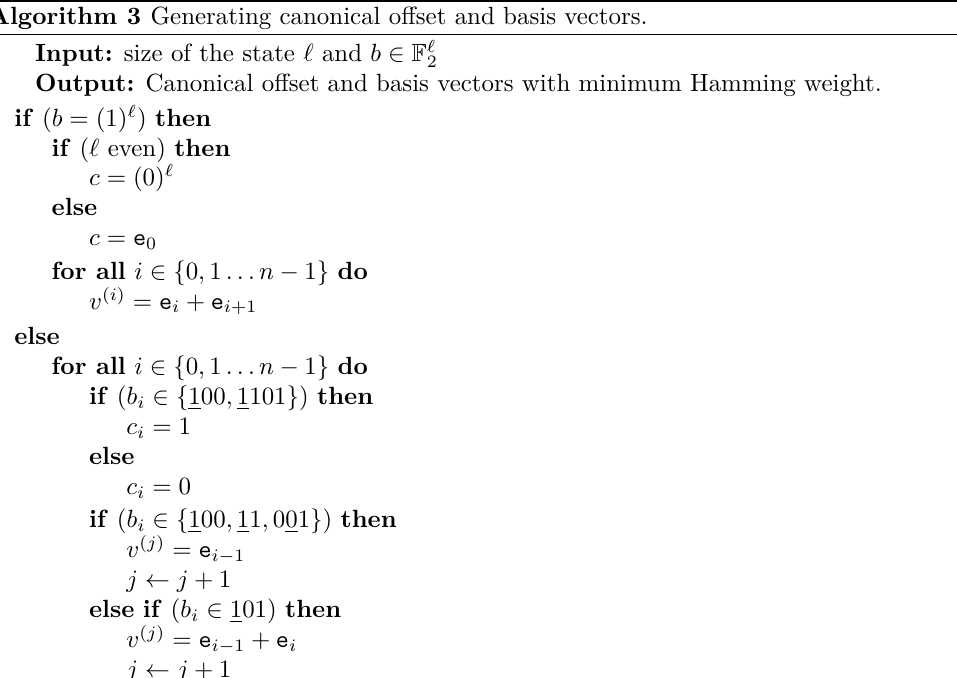
Algorithm 3 Generating canonical offset and basis